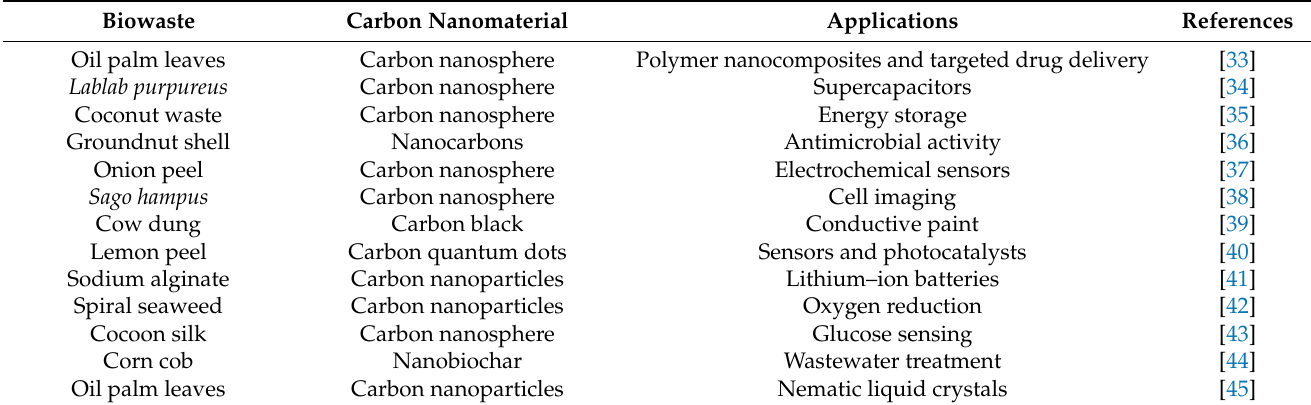
Table 2. Carbon nanomaterials synthesized from biowaste and their